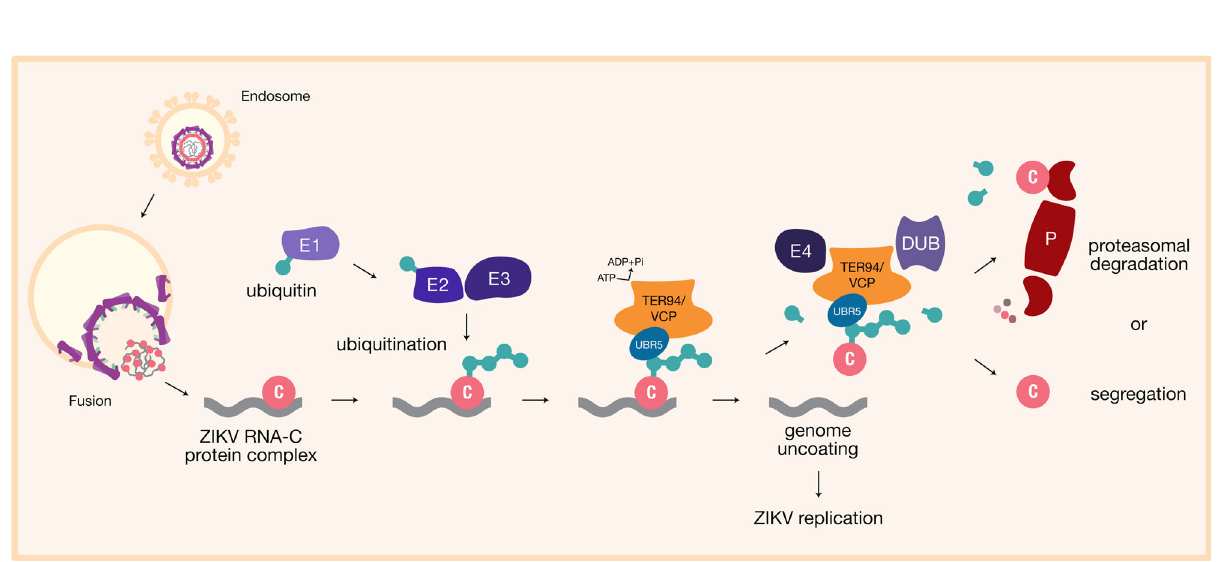
Fig. 6 Proposed model of TER94/VCP-mediated ZIKV uncoating. Ubiquitination of ZIKV C by ligases (E1, E2, and E3) allows interaction with